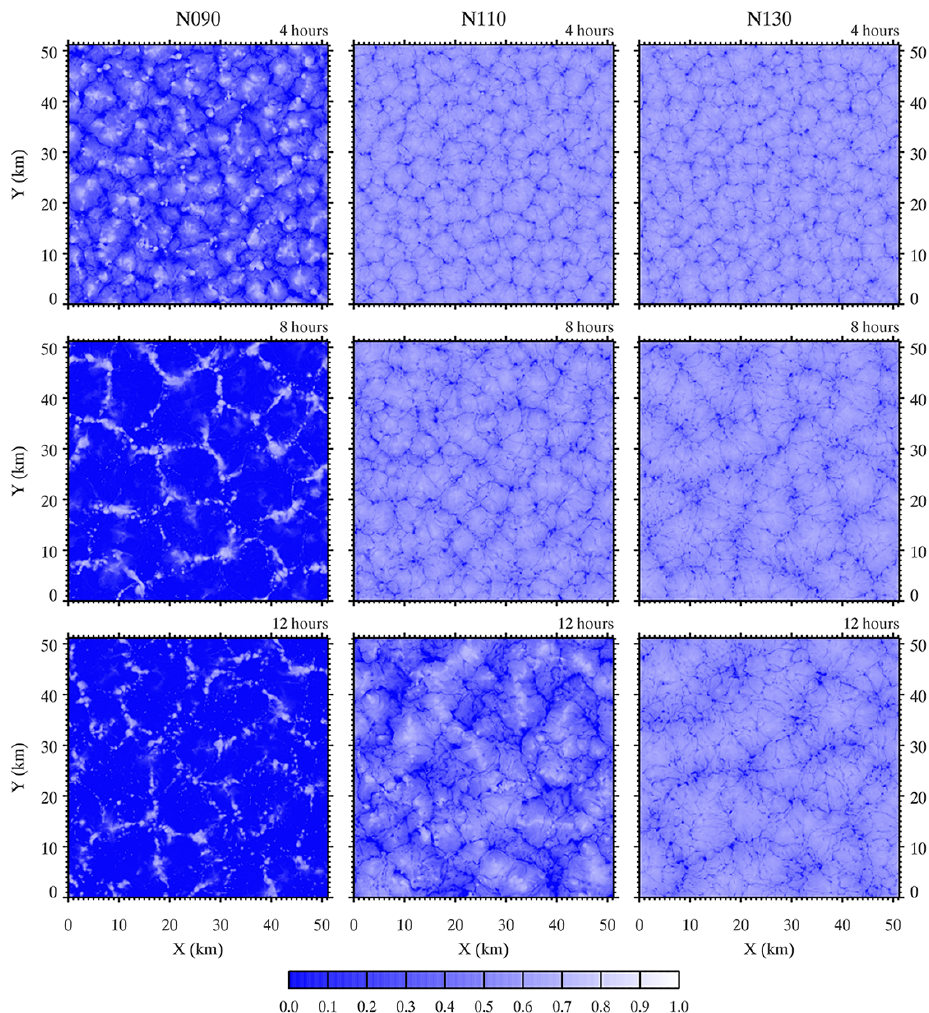
Figure 2. Time evolution of the computed albedo for N090, N110 and N130 of